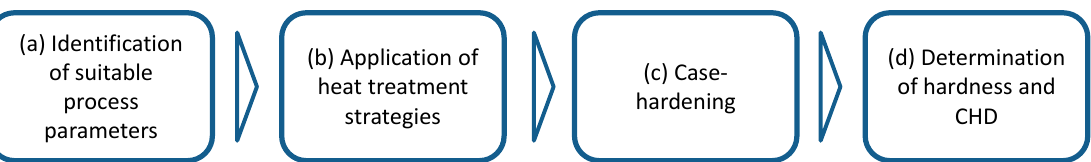
Figure 2. Experimental approach for the investigation of case-hardening behavior of additively manufactured 16MnCr5.